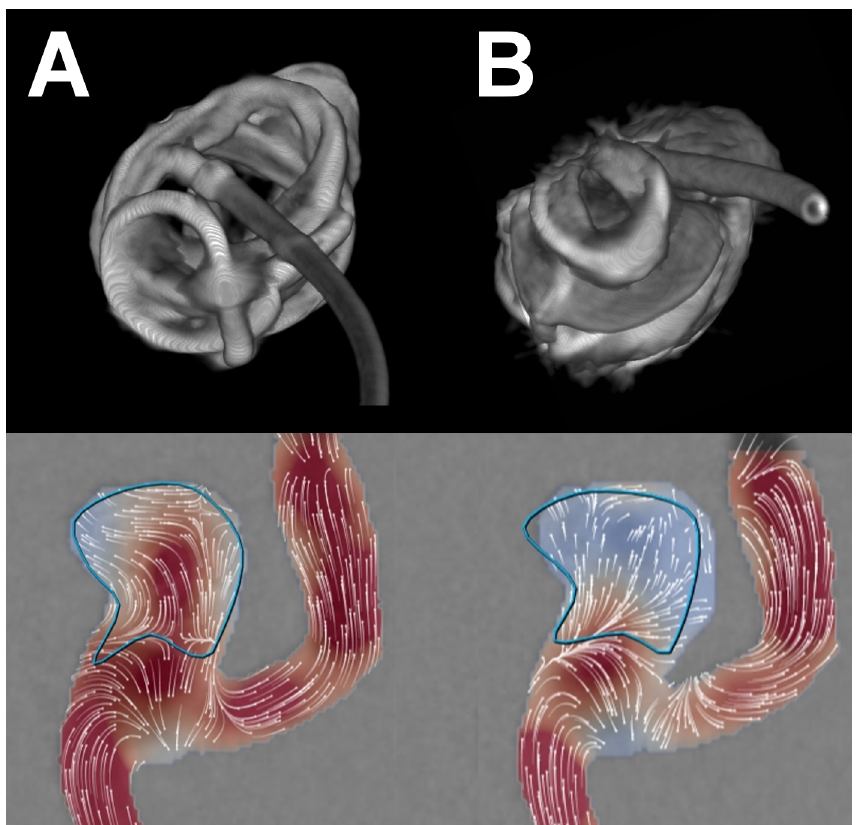
Fig 2. Neck coverage. Upper row shows volume reconstructions from VasoCT of two different MED configurations after implantation in the same aneurysm model (aneurysm 2), viewed from the direction of the aneurysm ostium. Incomplete neck coverage is appreciated in the first configuration (A, top), corresponding to moderate flow velocity reduction (41%) on high-frequency DSA (A, bottom). A different configuration showing better coverage of the neck by the MED petals (B, top) was accompanied by a higher degree of intra-aneurysmal flow velocity reduction (73%, B, bottom).